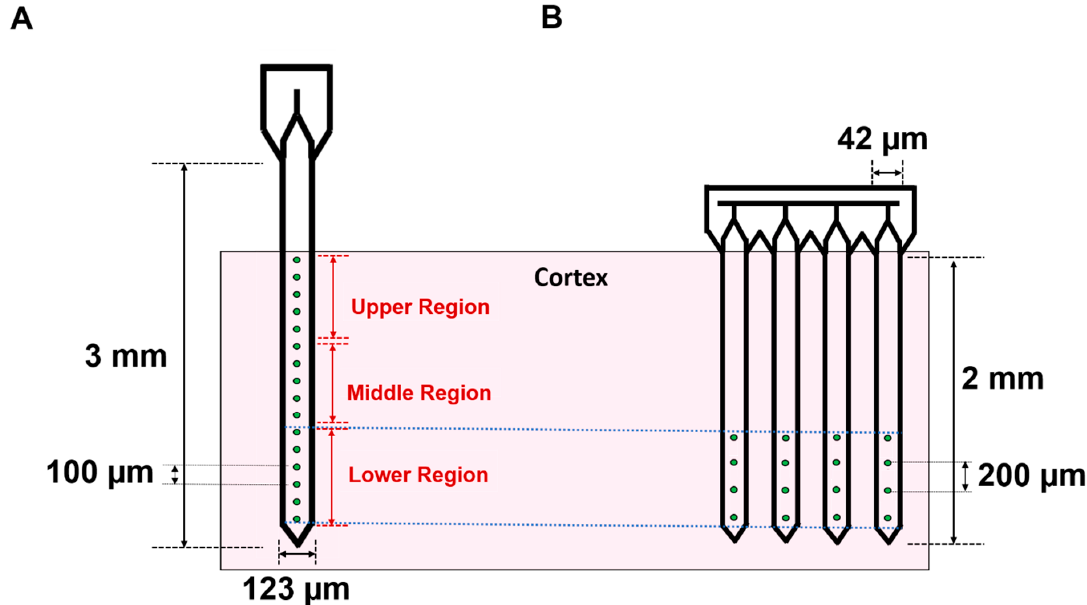
Figure 1. Dimensions and configurations for single shank and multi-shank microelectrode arrays. Depth-based differences in microelectrode placement for single shank ( A ) and multi-shank ( B ) microelectrode devices, highlighting the differences between experimental groups. Pink shaded region indicates the cortex of the brain while dashed lines indicate that micro- electrodes in the lower third of single shank arrays are implanted and aligned to the depth of multi-shank